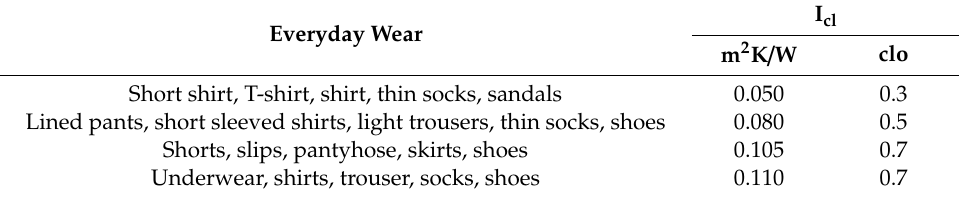
Table 2. Clothing insulation numerical reference [26].